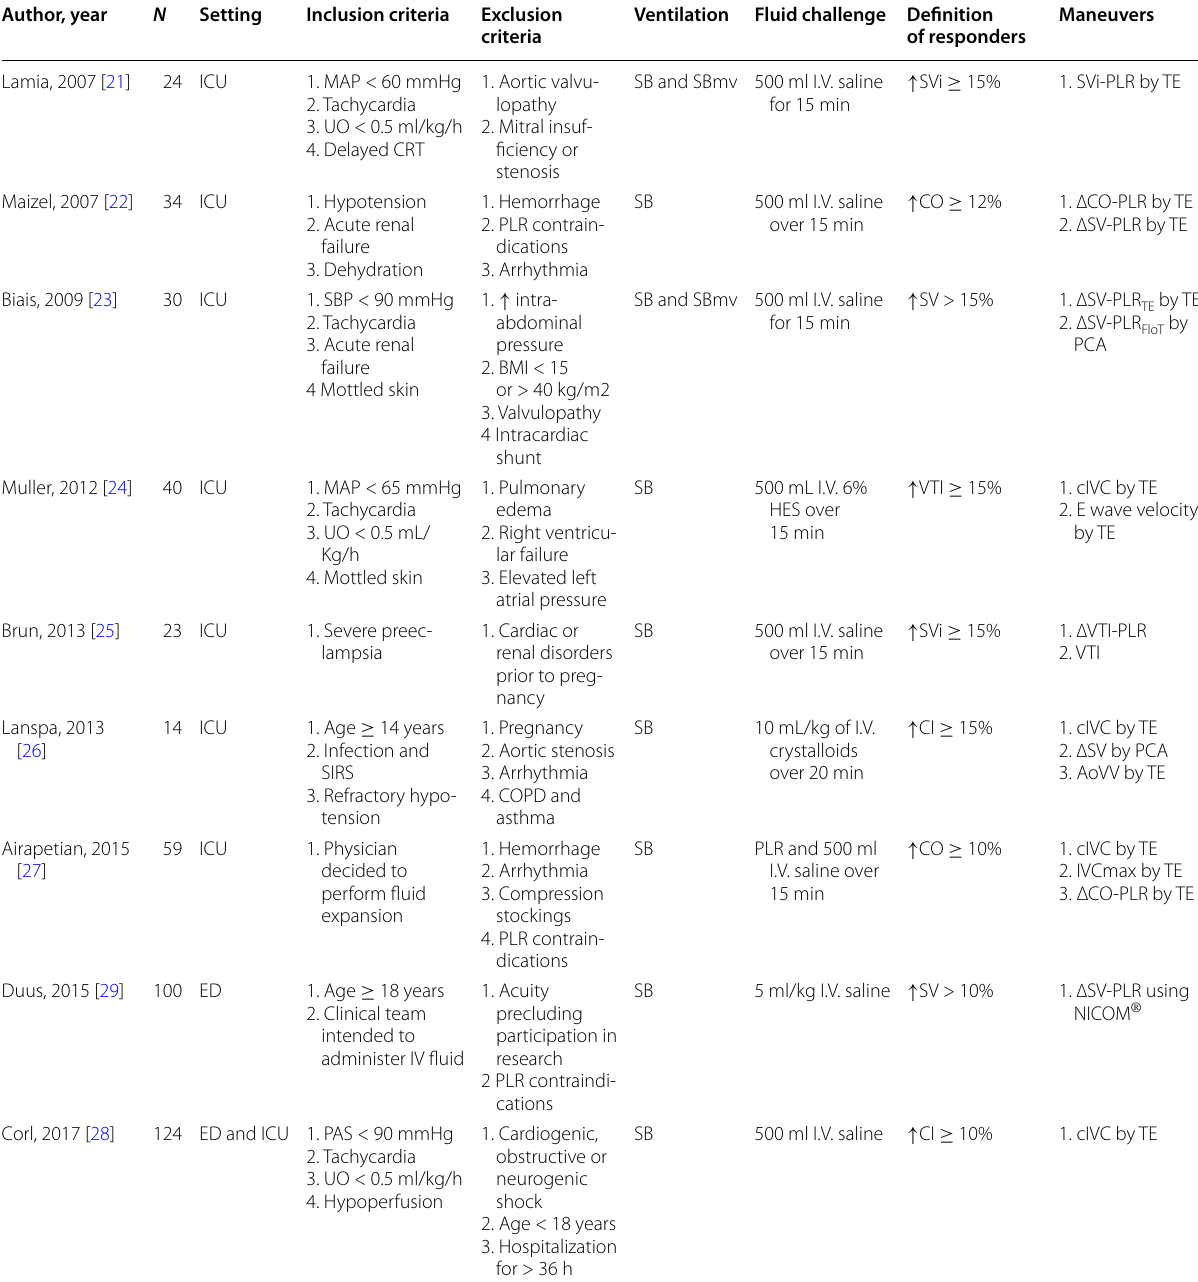
Table 2 Characteristics of included studies addressing echocardiography maneuvers, pulse contour analysis or